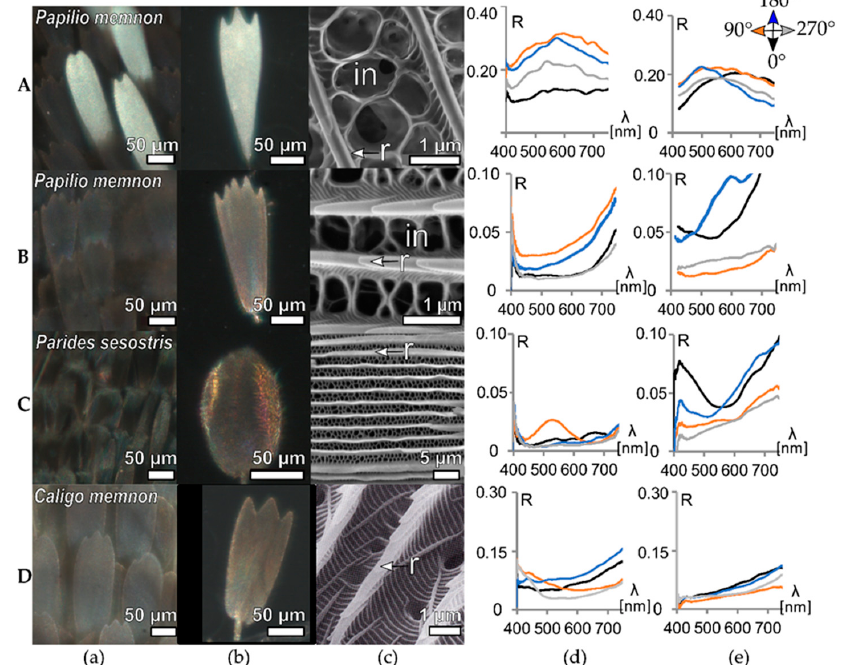
Figure 2. Pigmentary coloured butterflies with common grating structures. Row ( A ) Papilio memnon (white area), ( B ) Papilio memnon (black area), ( C ) Parides sesostris (black area), and ( D ) Caligo memnon (brown area) . Column ( a ) shows optical micrographs (all oriented tip-up for convenience) of the scales arranged on the wing and column ( b ) shows optical micrographs of single wing scales. Column ( c ) shows SEM images of the scale ultrastructures. Column ( d ) displays orientation-dependent reflectance of the wing patches and ( e ) displays orientation-dependent reflectance of the single scales. In column c, in marks the irregular net of connecting cross-ribs and r marks the scale ridges. In column ( d , e ), R represents reflectance and λ represents wavelength. The SEM image at panel Dc was reproduced with permission [1], Wiley, 1998.